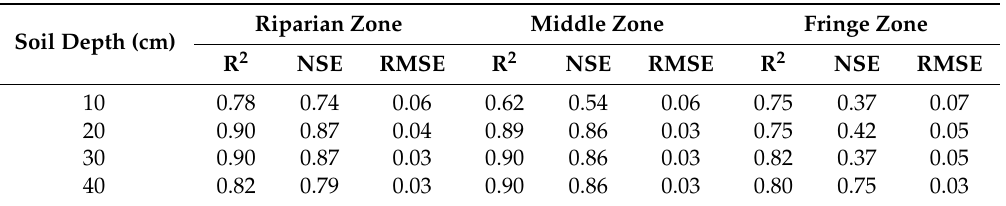
Table 9. Hydrus-1D performance for soil moisture simulation after using averaged hydraulic parameters calculated from all of the calibrated plots for each hydrological zone.